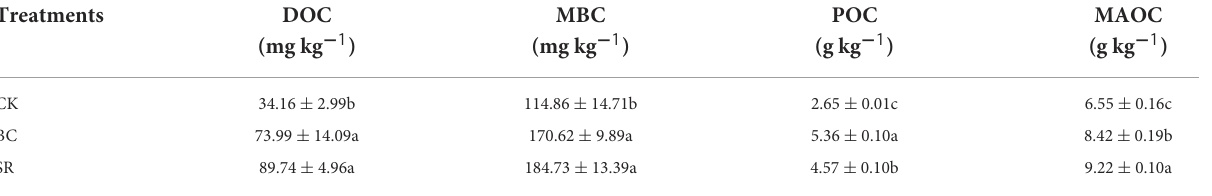
TABLE 1 Effect of straw and straw biochar on SOC fractions.